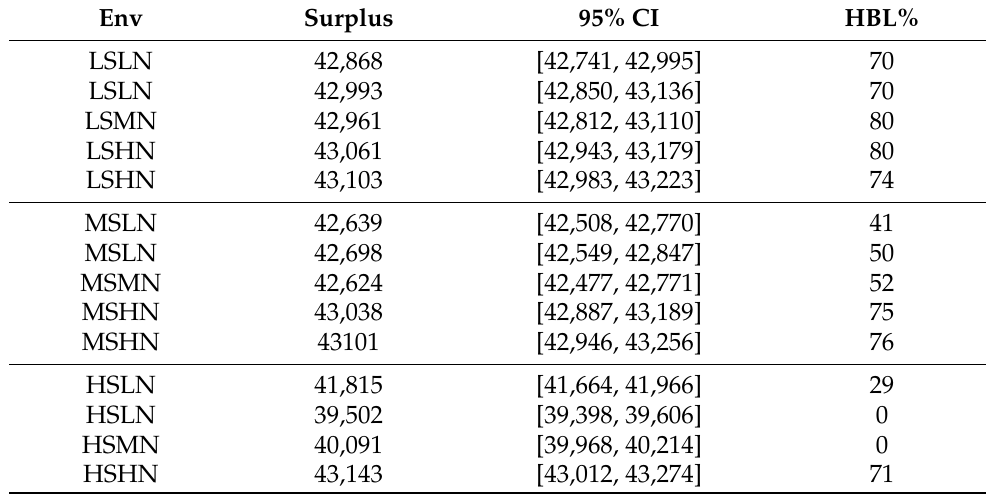
Table A4. Similar to Table A3 above, but with N = 65 with spoofing.